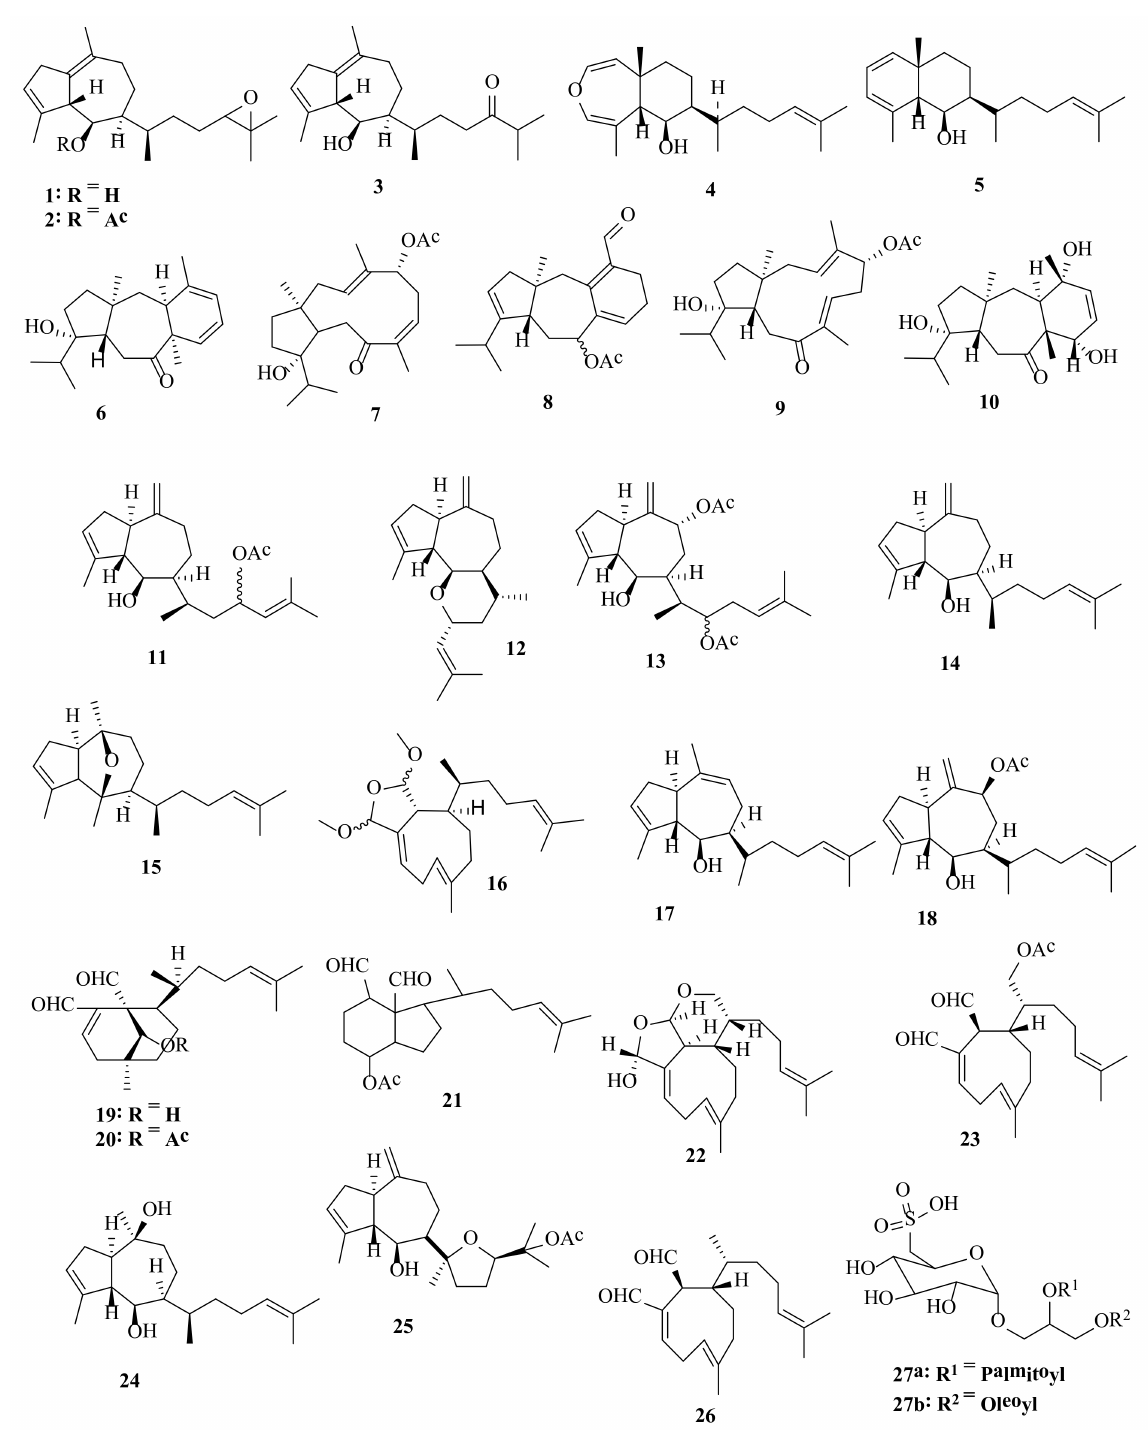
Figure 2. Chemical structures of compounds 1 – 27 . Diterpenes 1 – 5 were isolated from D. acutiloba , diterpenes 6 – 10 were isolated from D. bartayresiana , diterpenes 11 – 16 were isolated from D. binghamiae , diterpenes 17 – 21 were isolated from D. caribaea , and diterpenes 22 – 26 and sulfonoglycolipid 27 were isolated from D. ciliolata . The configuration of all stereocenters in each compound is shown as given in the